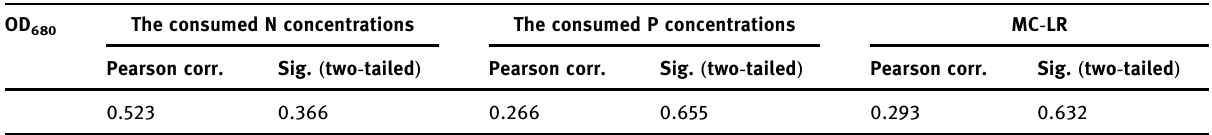
Table 2: Correlation between the algal density ( OD 680 ) and the consumed concentrations of N ( P ) , MC - LR production at varying N and constant P OD